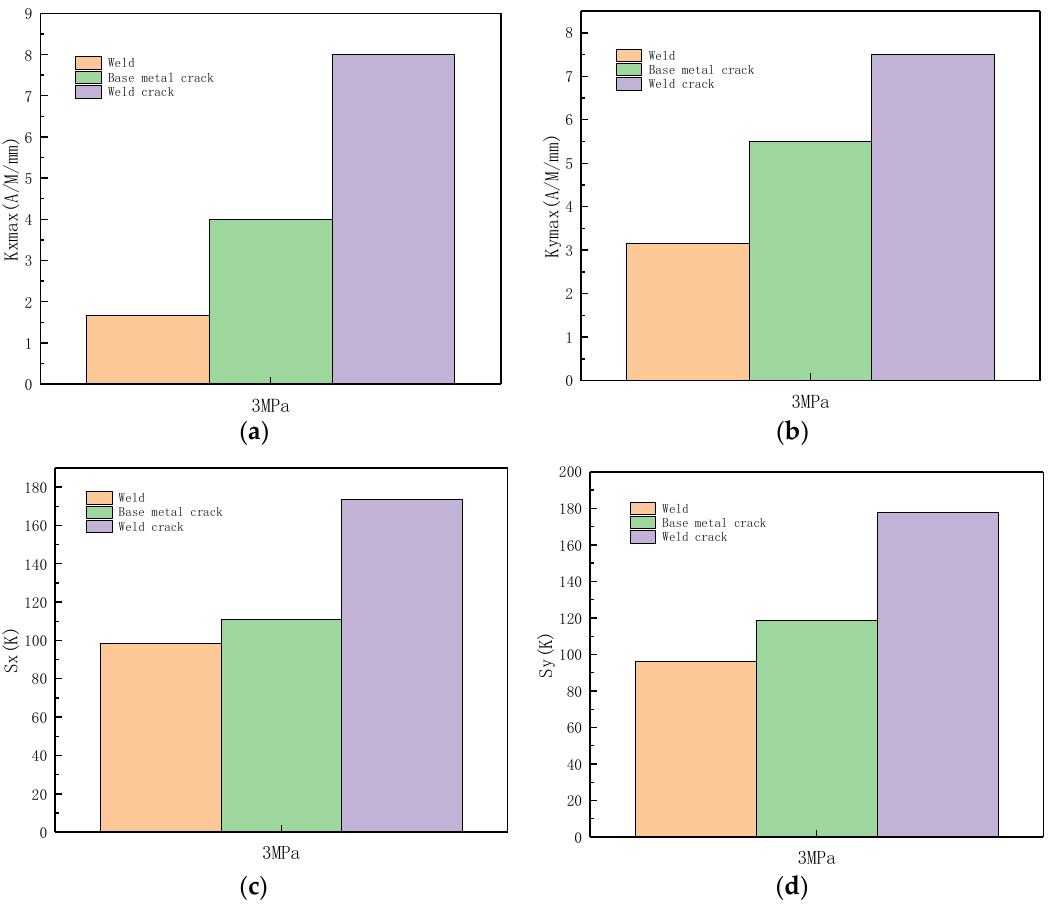
Figure 41. Variations of Kmax and S ( K ) parameters at an internal pressure of 3 MPa. ( a ) Axial component of Kmax ; ( b ) radial component of Kmax . ( c ) Axial component of S ( k ); ( d ) radial component of S ( k ).